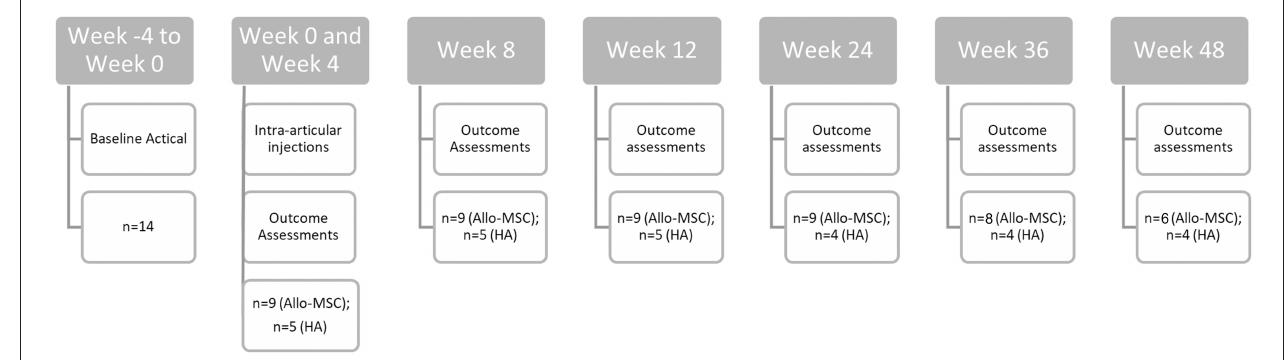
FIGURE 1 | Graphical representation of the study timeline and sample